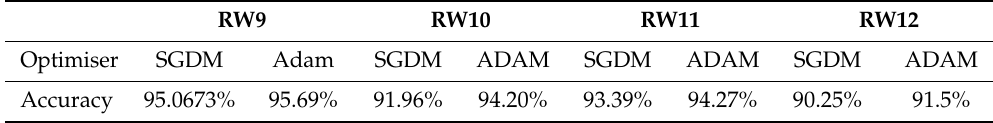
Table 5. Capacity prediction accuracy for each battery cell using AlexNet.